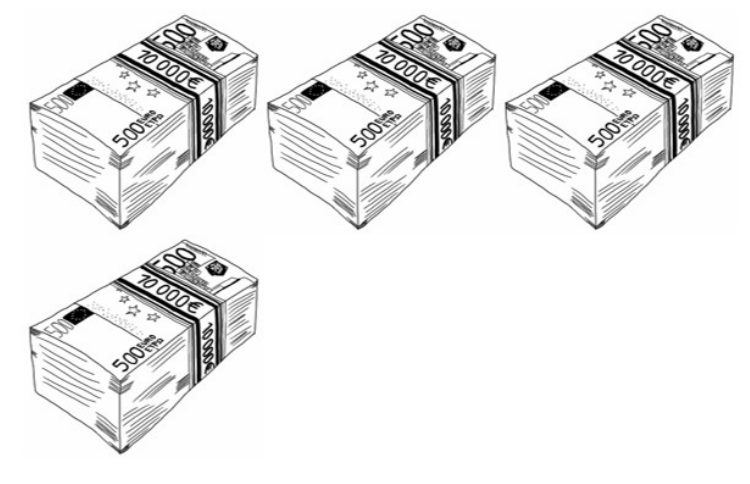
Figure 2 - Conceptualization of ‘moneys’